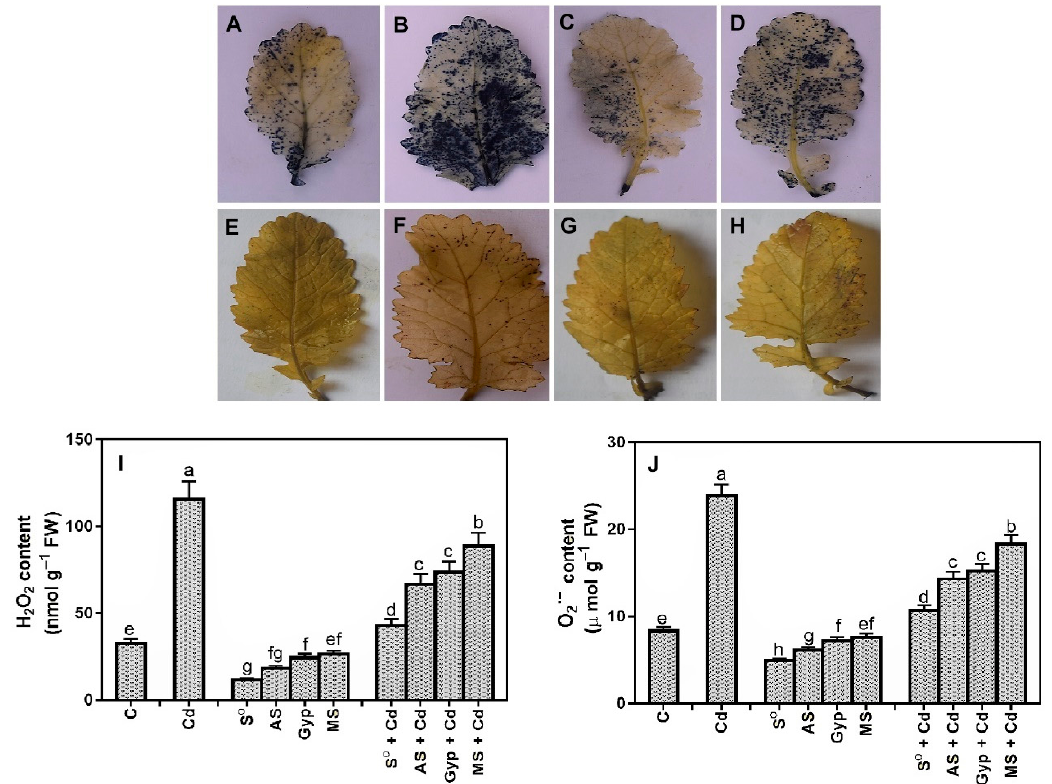
Figure 4. Accumulation of superoxide anion (O 2• − ) and hydrogen peroxide (H 2 O 2 ) in leaves of Brassica juncea cv Giriraj stained with ( A – D ) NBT and ( E – H ) DAB, respectively, under ( A , E ) control 0 mg Cd kg − 1 soil + 0 mg S kg − 1 soil, ( B , F ) 200 mg Cd kg − 1 soil, ( C , G ) 200 mg S kg − 1 soil, and ( D , H ) 200 mg Cd kg − 1 soil + 200 mg S kg − 1 soil. ( I ) H 2 O 2 content and ( J ) O 2• − content in leaves of Brassica juncea cv Giriraj treated with 200 mg S kg − 1 soil of elemental S (S 0 ), ammonium sulfate (AS), gypsum (Gyp) or magnesium sulfate (MS), grown with or without cadmium (200 mg Cd kg − 1 soil). Data are presented as means ± SE ( n = 4). Data with the same letter are not significantly different by LSD test at p < 0.05. C, control; Cd, cadmium; DAB, 3,3 ′ -diamiobenzidine; FW, fresh weight, NBT, nitro blue tetrazolium.